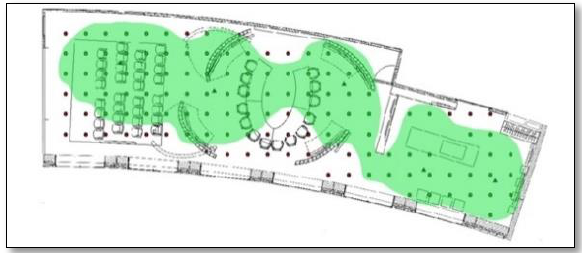
Figure 4: Tags in the green area are expected to return the positions with acceptable performance